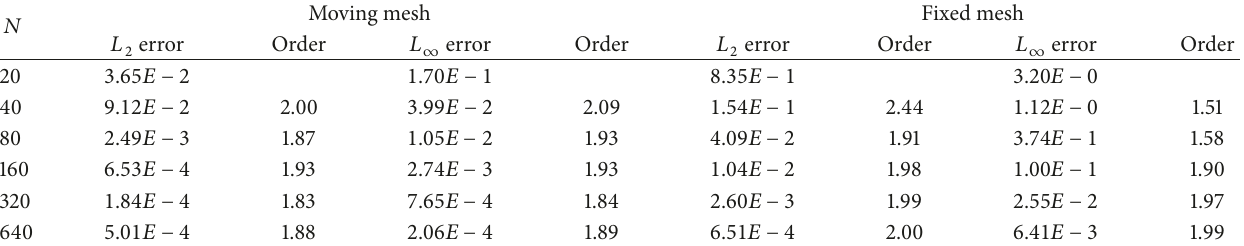
Table 1: Example 1. The 𝐿 2 and 𝐿 ∞ error and convergence order on moving and fixed meshes for the single solitary wave. 𝑁 Moving mesh Fixed mesh 𝐿 2